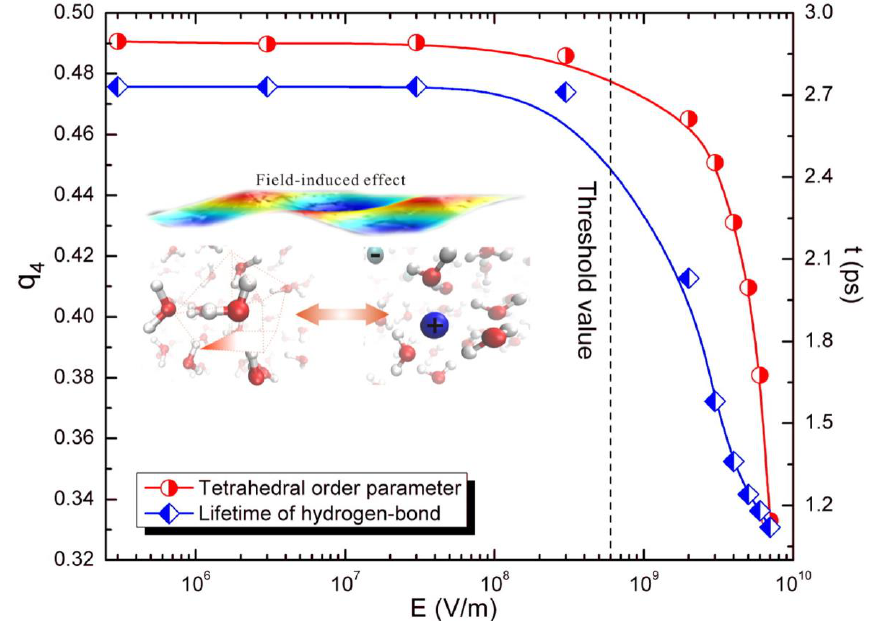
Figure 8. The field dependence of the tetrahedral order parameter and lifetime of hydrogen bonds.